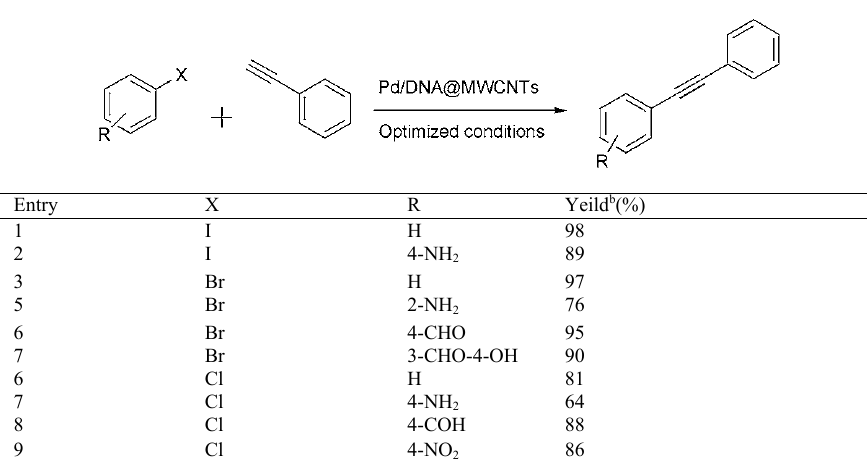
Table 3 . Sonogashira cross-coupling of various aryl halides in the presence of the catalyst. a